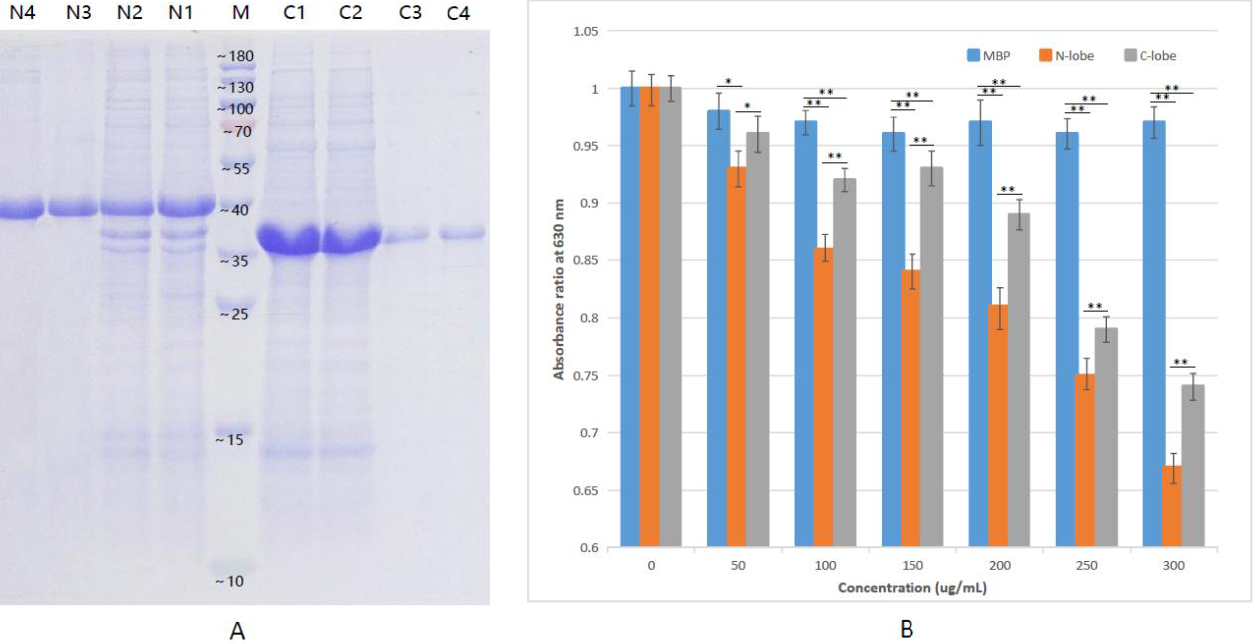
Figure 7. Analysis of iron-dependent bacterial growth inhibition. The x-axis represents time, and the y-axis represents the light absorption value at 600 nm. Values were described as mean ± SE ( n =